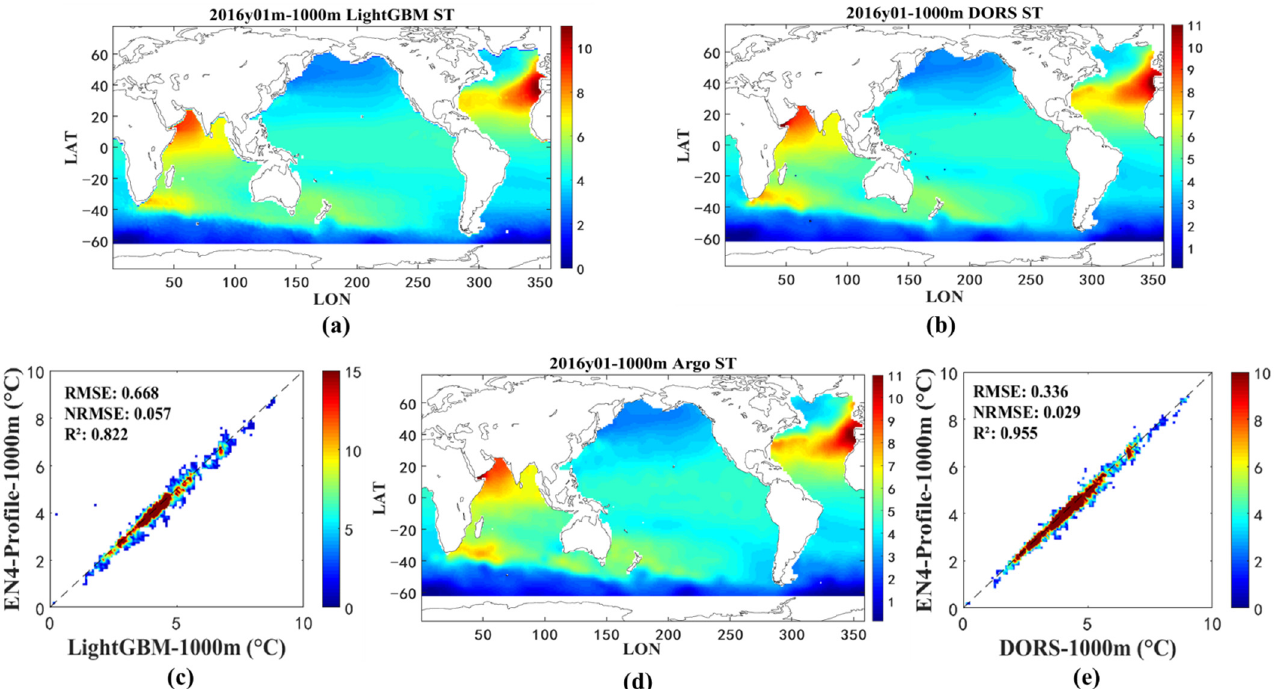
Figure 7. The spatial distribution of DORS, LightGBM, and Argo at 1000 m for January 2016, and intensity scatter plots: ( a ) is the LightGBM ST, ( b ) is the DORS ST, ( c ) is the intensity scatter plots between the LightGBM ST and the EN4-Profile ST, ( d ) is the Argo ST, and ( e ) is the intensity scatter plots between the DORS ST and the EN4-Profile ST.